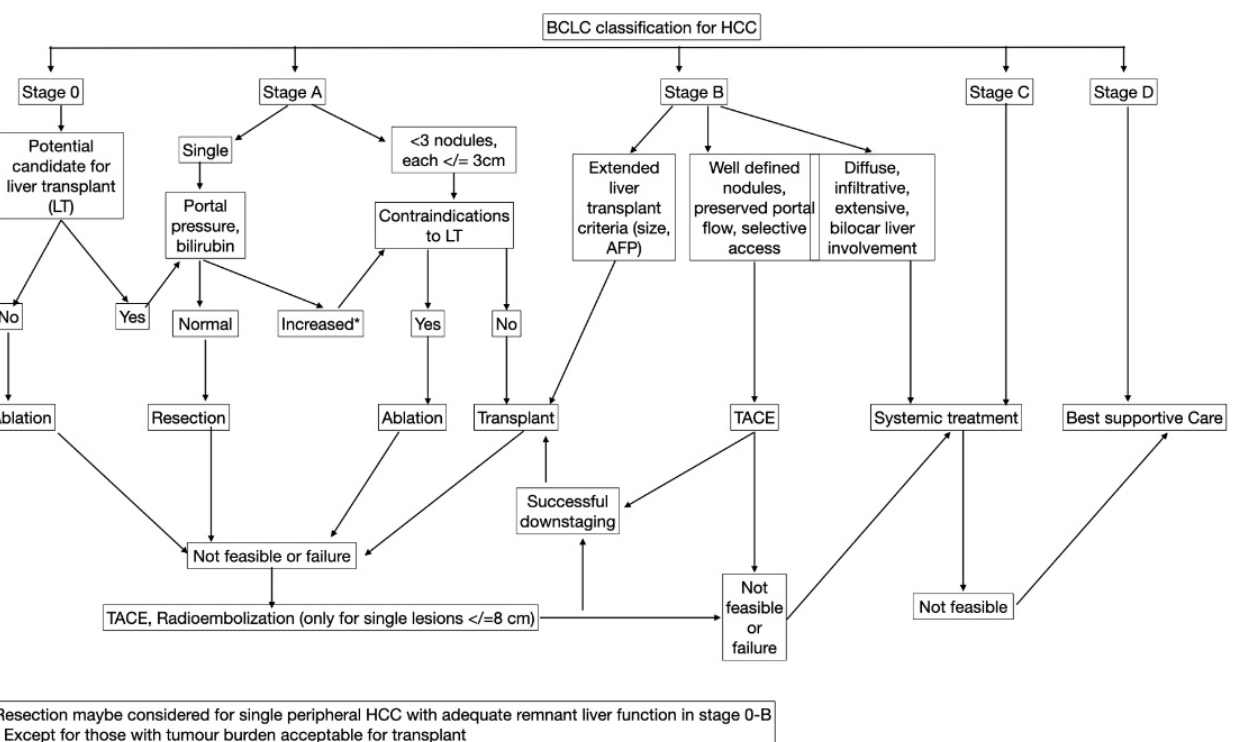
Figure 2. Indications for the use of transarterial therapies in patients with hepatocellular carcinoma (HCC).